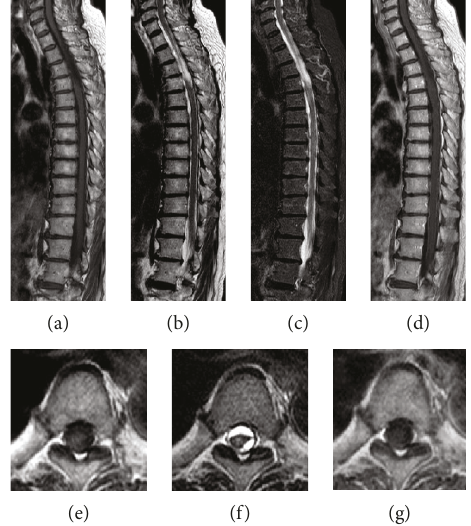
Figure 3: Sagittal (T1-weighted (a), T2-weighted (b), STIR (c), and contrast-enhanced (d)) and axial (T1-weighted (e), T2-weighted (f), and contrast-enhanced (g)) magnetic resonance imaging showed resolution of the subdural hematoma and deformity of the spinal cord indicating adhesive arachnoiditis at 6 months after